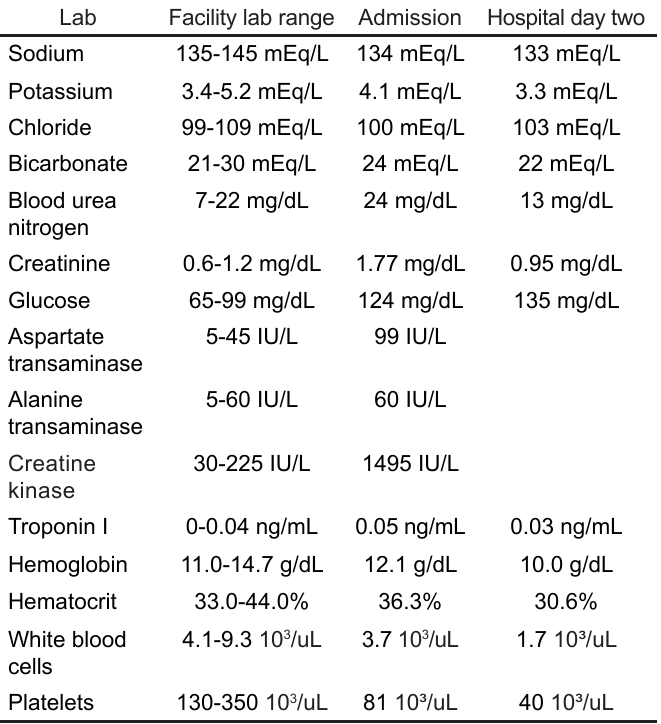
Table 1. Lab results for 80-year-old patient with history of tick